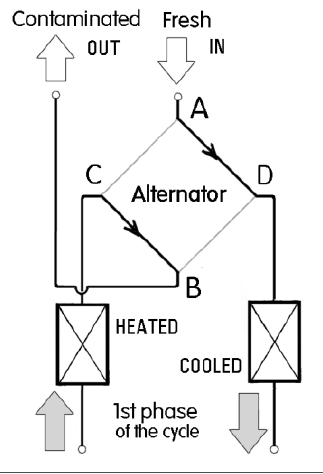
Fig. 21. Air flows in the other phase of the alternator than in Fig, 20. The fresh air here now flows through B.